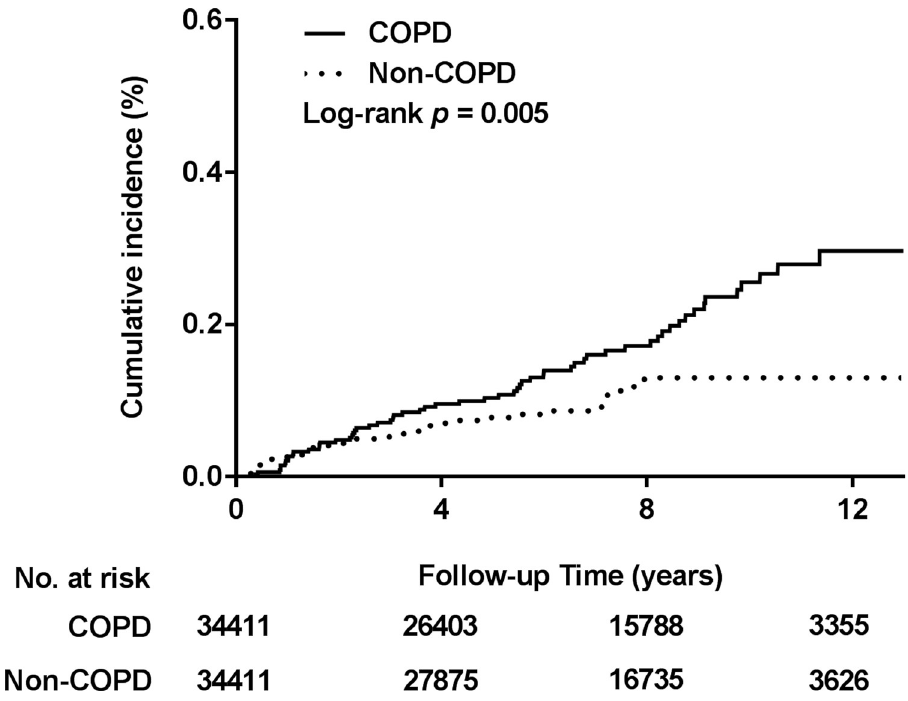
Fig 2. Cumulative incidence of epiglottitis for COPD versus non-COPD. The COPD group had significantly higher cumulative incidence of epiglottitis (log-rank test, p = 0.003).